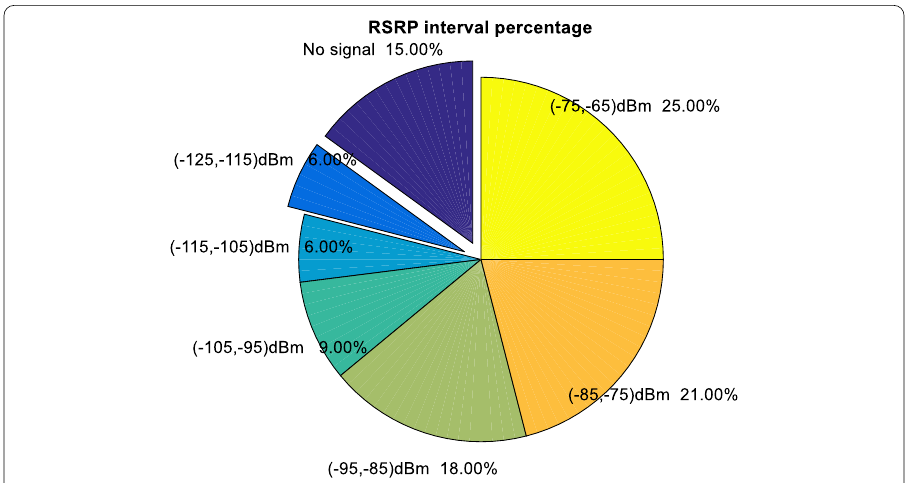
Fig. 5 RSRP values of 298 distribution points in the TD‑LTE signal coverage